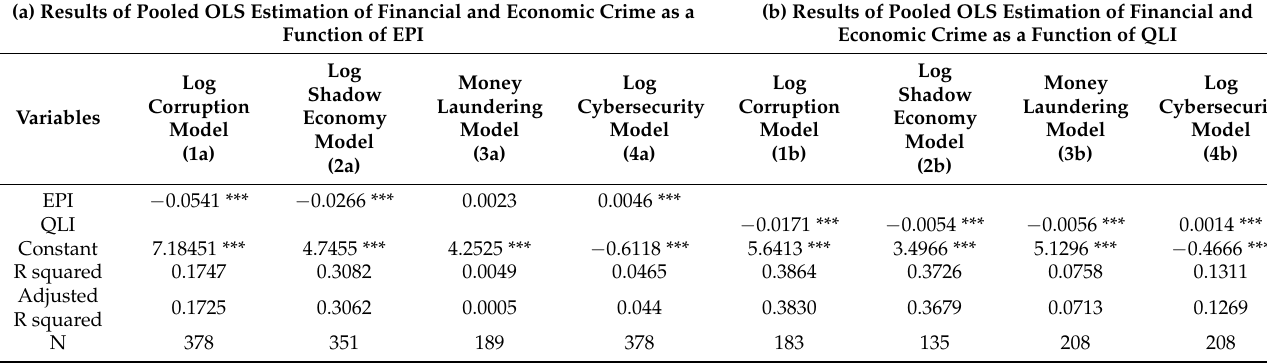
Table 2. Simple regression modeling—Robustness checks (1).